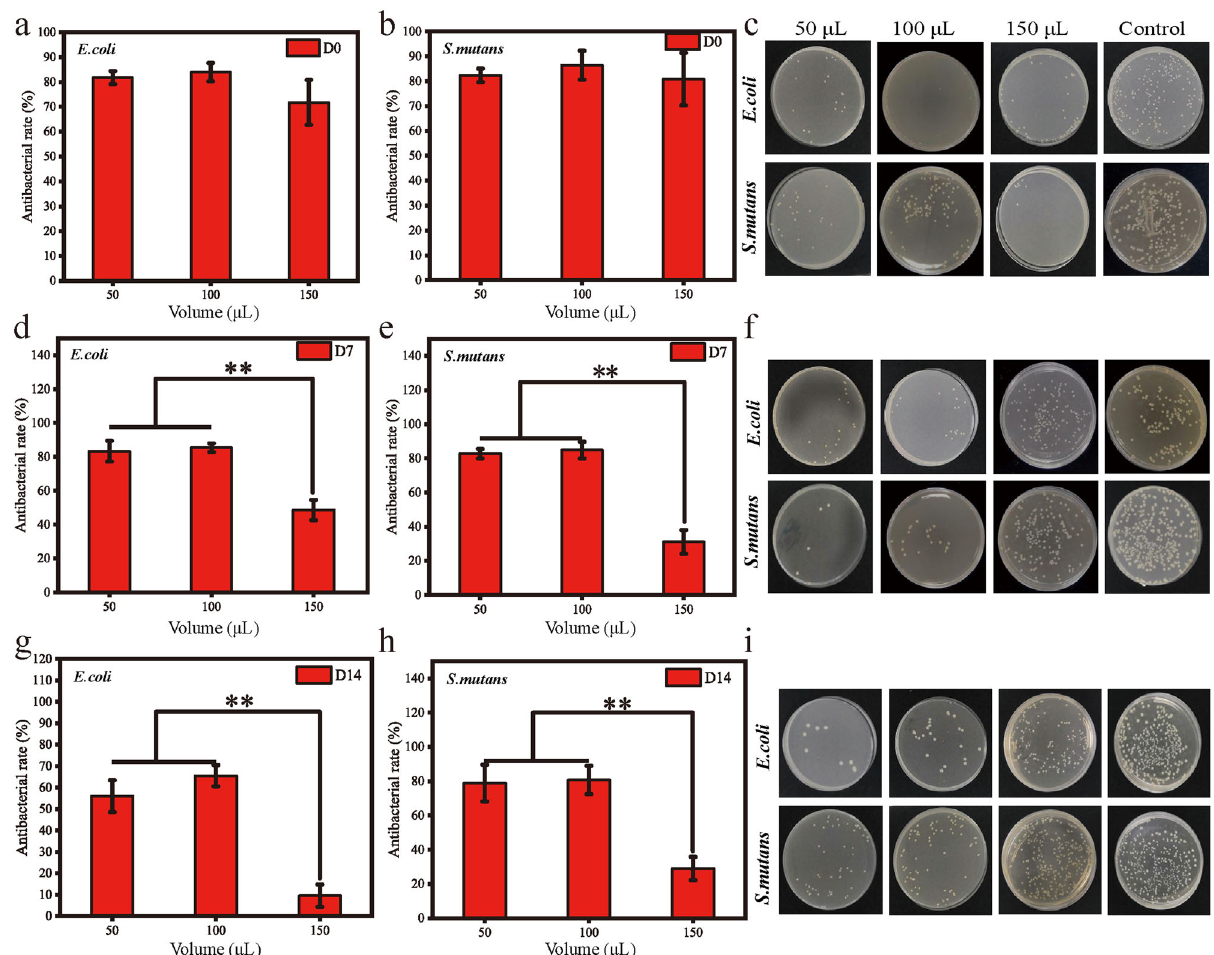
Fig. 5 Long-term antibacterial performance of PDA-HCDs coating. a , b The antibacterial rates of PDA-HCDs coatings with different volumes of HCDs solutions (50 µL, 100 µL and 150 µL) against E. coli ( a ) and S. mutans ( b ). Pristine brackets were used as controls. c The